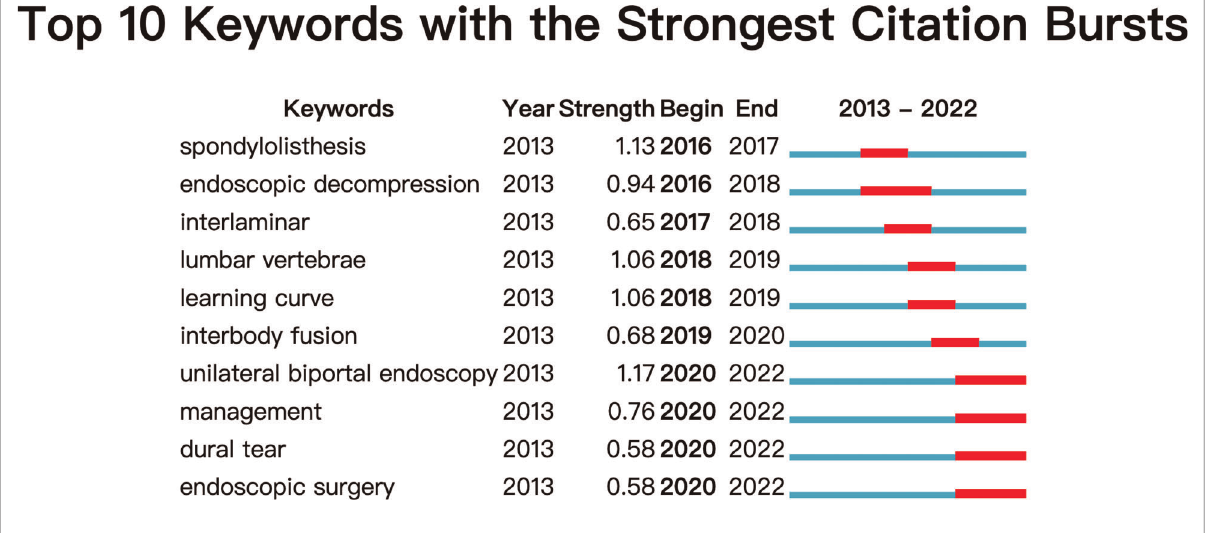
FIGURE 7 Top 10 keywords with the strongest citation